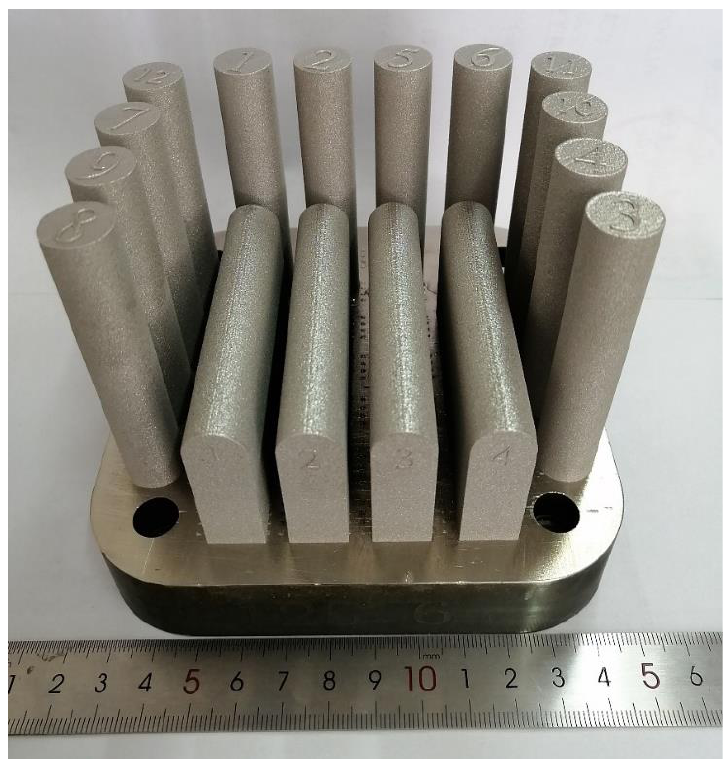
Figure 2. The size and distribution of the SLM processed